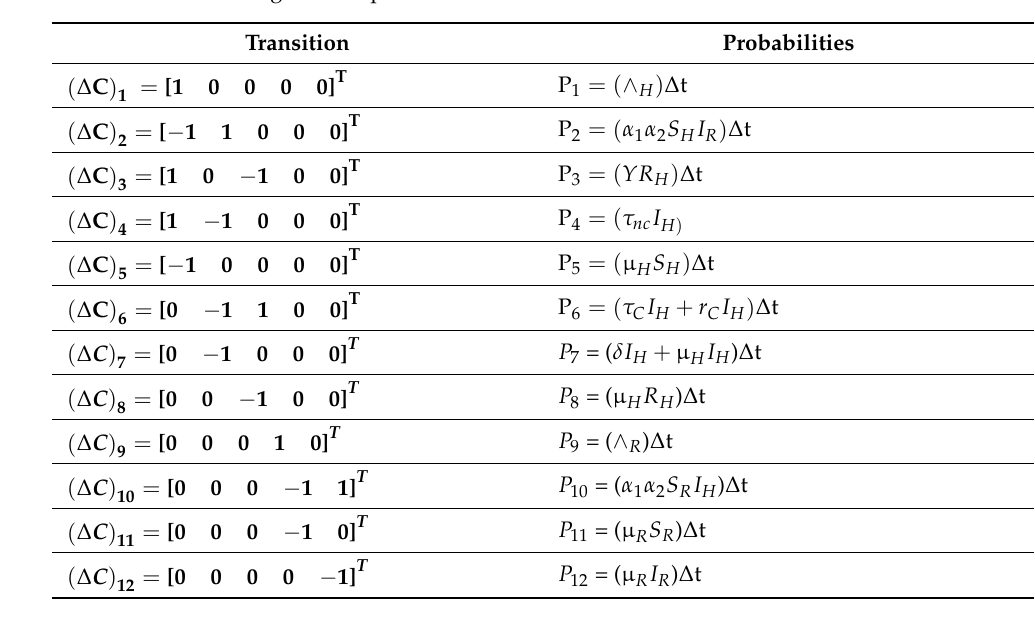
Table 2. Possible changes in the process of the